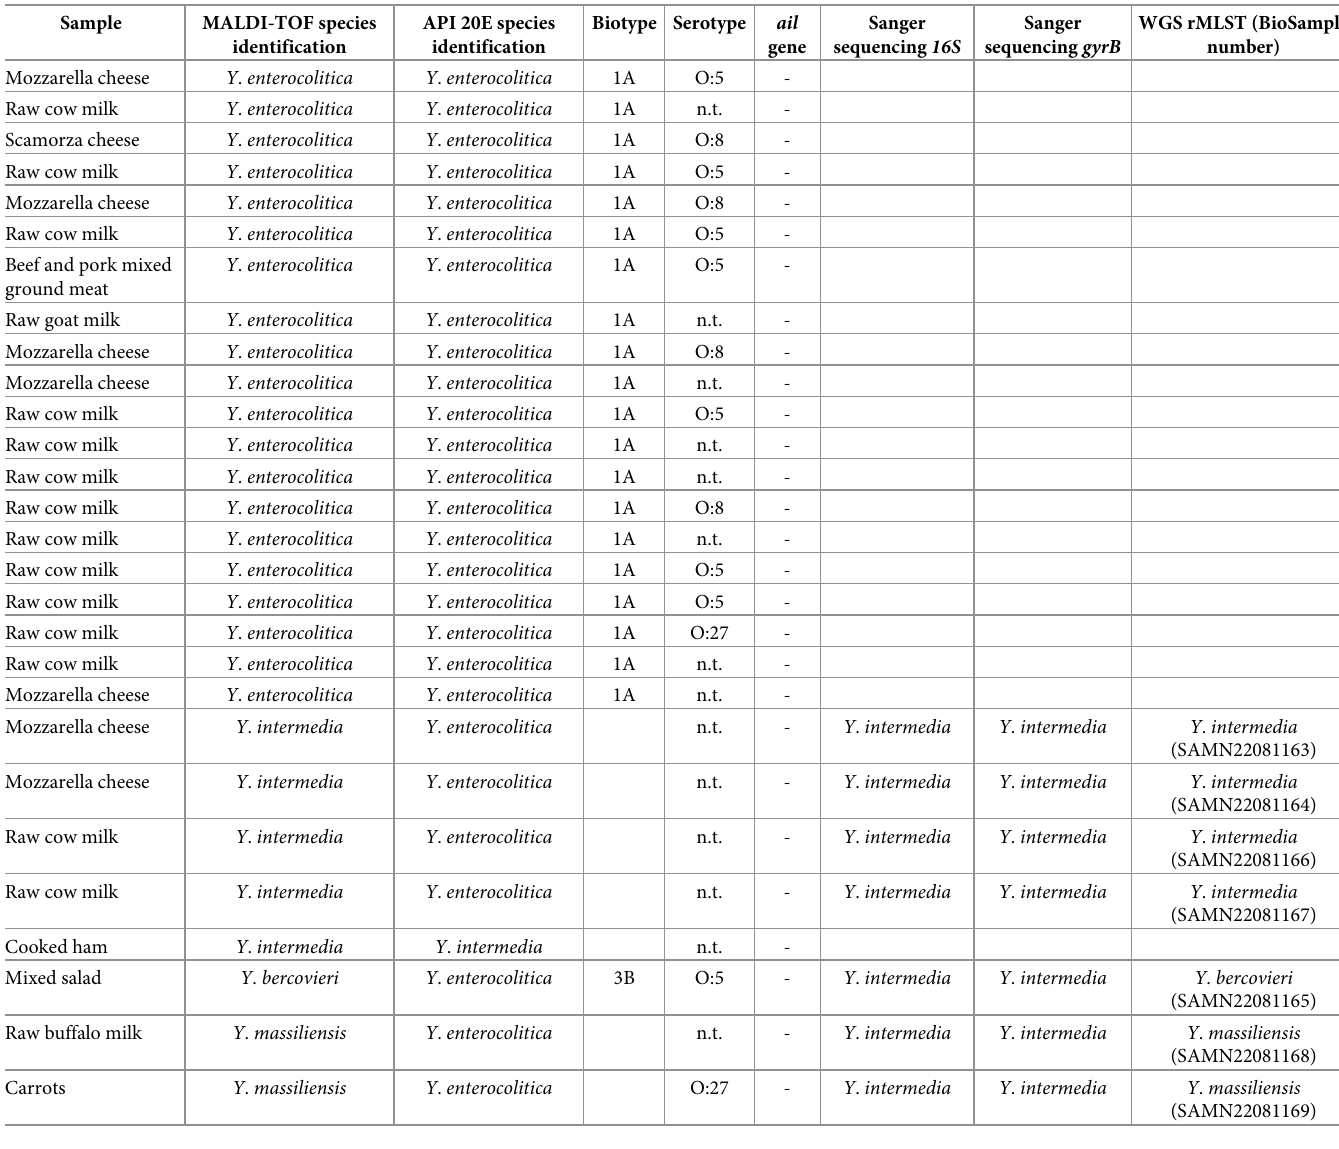
Table 2. Results on identification and typing of Yersinia isolates: Comparison among different analytical methodologies. Sample MALDI-TOF species